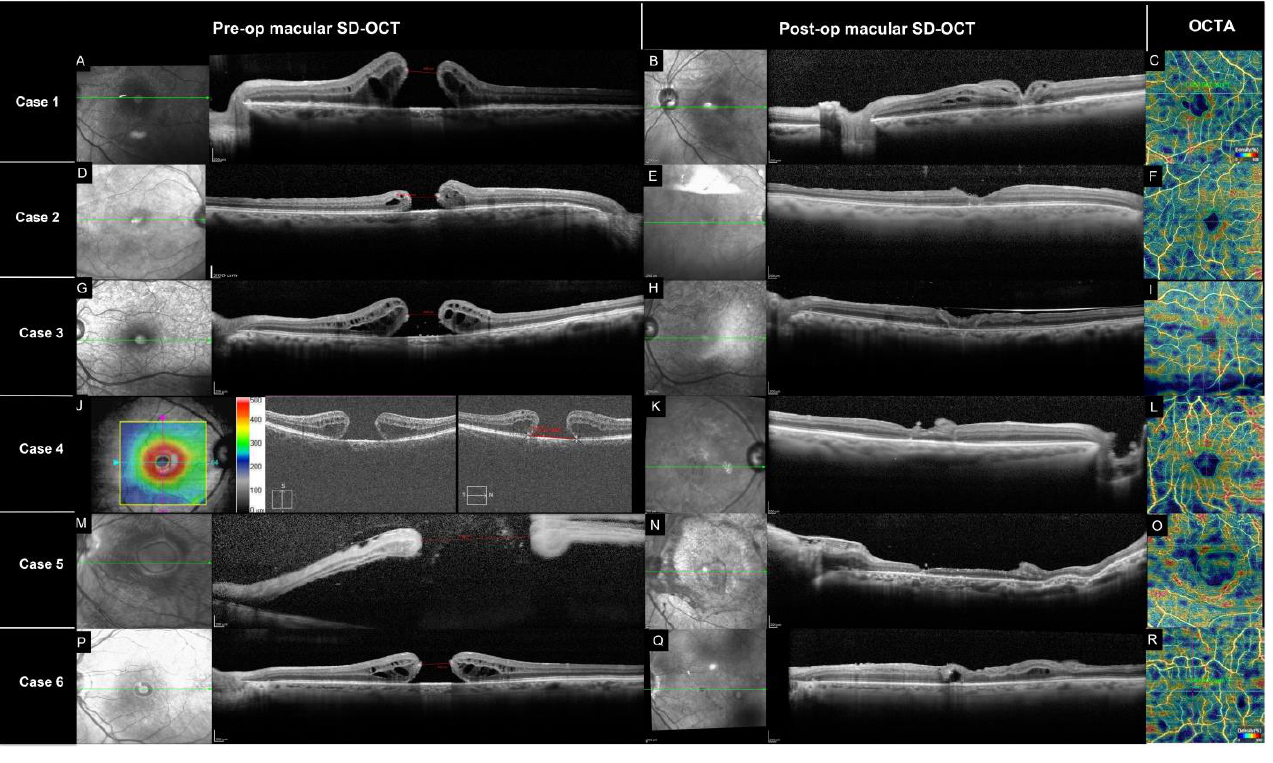
Figure 2. SD-OCT of pre-op and post-op (6 months) MH and ART. OCT-A density map. Case 1 ( A – C ): ( A ) Left eye pre-operative macular SD OCT with MH and intraretinal cyst (Spectralis, Heidelberg Engineering, Heidelberg, Germany). ( B ) Post-operative macular SD-OCT with central ART, presence of some intraretinal cyst. ( C ) Density map (Topcon, Triton, Topcon Healthcare). Case 2 ( D – F ): ( D ) Right eye pre-operative macular SD OCT (Spectralis, Heidelberg Engineering, Heidelberg, Germany). ( E ) Post-operative macular SD-OCT with central ART. (F) Density map (Topcon, Triton, Topcon Healthcare). Case 3 ( G – I ): ( G ) Left eye pre-operative macular SD OCT MH with intraretinal cyst (Spectralis, Heidelberg Engineering, Heidelberg, Germany). ( H ) Post-operative macular SD-OCT with ART. ( I ) Density map (Topcon, Triton, Topcon Healthcare). Case 4 ( J – L ): ( J ) Right eye pre-operative macular OCT (Cirrus HD-OCT 4000, Zeiss) 1154 um. ( K ) Post-operative macular SD-OCT with ART. ( L ) Density map (Topcon, Triton, Topcon Healthcare). Case 5 ( M – O ): ( M ) Left eye pre-operative macular SD OCT, subretinal fluid (Spectralis, Heidelberg Engineering, Heidelberg, Germany). ( N ) Post-operative macular SD-OCT with ART. ( O ) Density map (Topcon, Triton, Topcon Healthcare). Case 6 ( P – R ): ( P ) Left eye pre-operative macular SD OCT and intraretinal cyst (Spectralis, Heidelberg Engineering, Heidelberg, Germany). ( Q ) Post-operative macular SD-OCT with ART and intraretinal cyst. ( R ) Density map (Topcon, Triton, Topcon Healthcare). MLD (minimum lineal dimension), FAZ (foveal avascular zone), MH (macular hole).